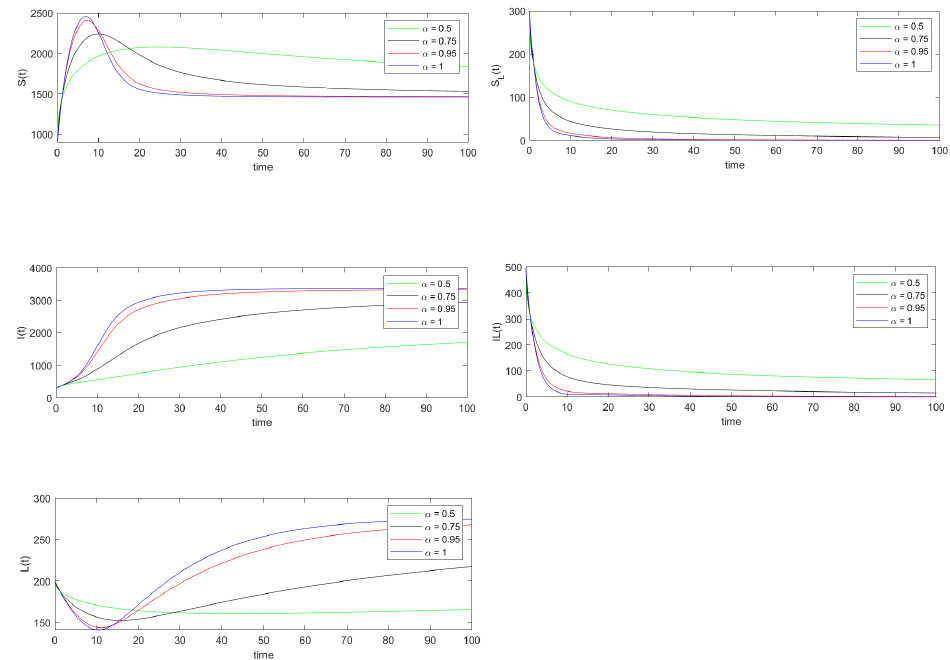
Figure 3. Numerical simulation of the trajectories of the solution of system (8) when R 0 >